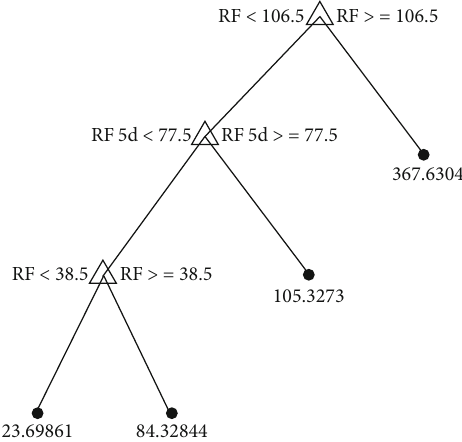
Figure 15: Decision tree for group B (seepage, rainfall, antecedent 5-day rainfall, and water